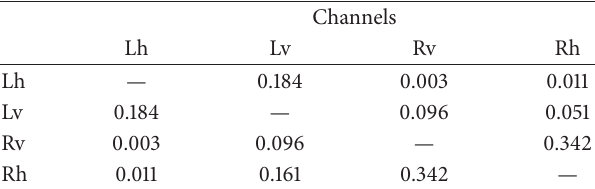
Table 2: Cross-correlation coefficients—elevation angle of 7.1 ∘ with closer antenna distance.